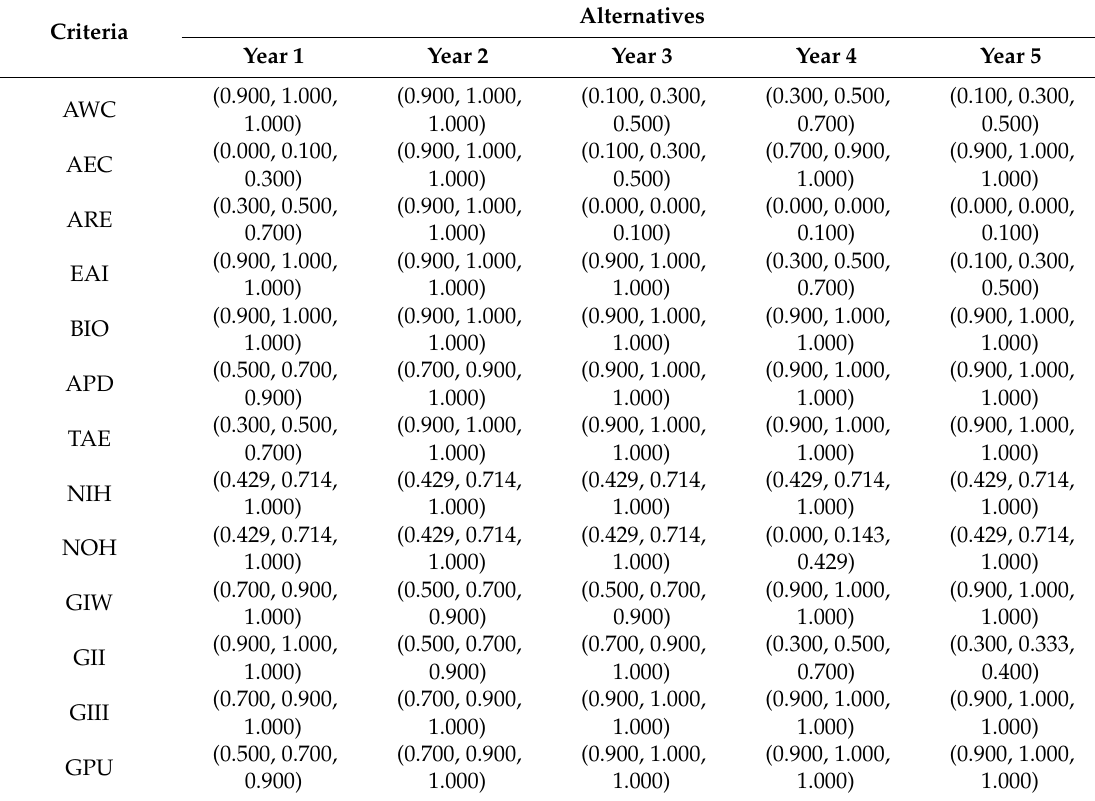
Table 7. The fuzzy weighted normalised decision matrix obtained from combining the judgements of the expert and patient group.